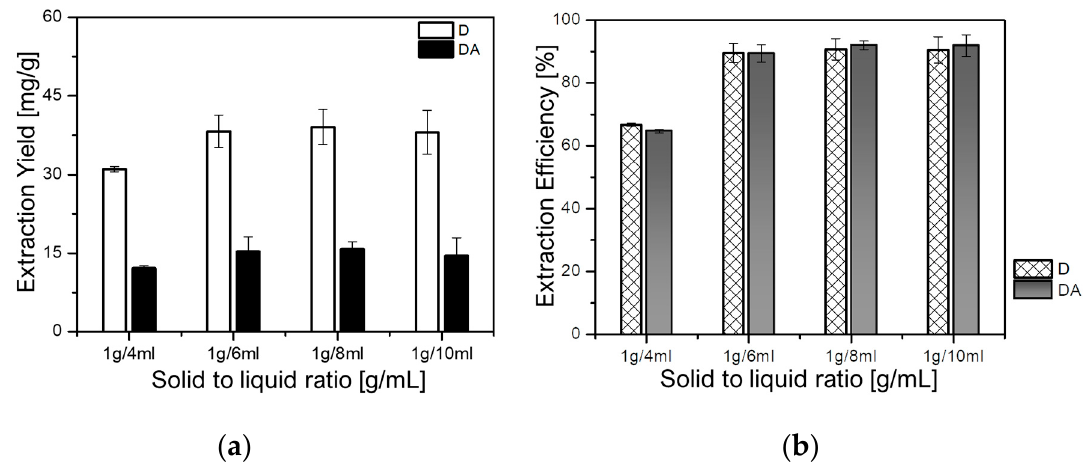
Figure 5. Effect of the solid-to-liquid ratio on: ( a ) extraction yields of D and DA and ( b ) extraction efficiencies of D and DA.